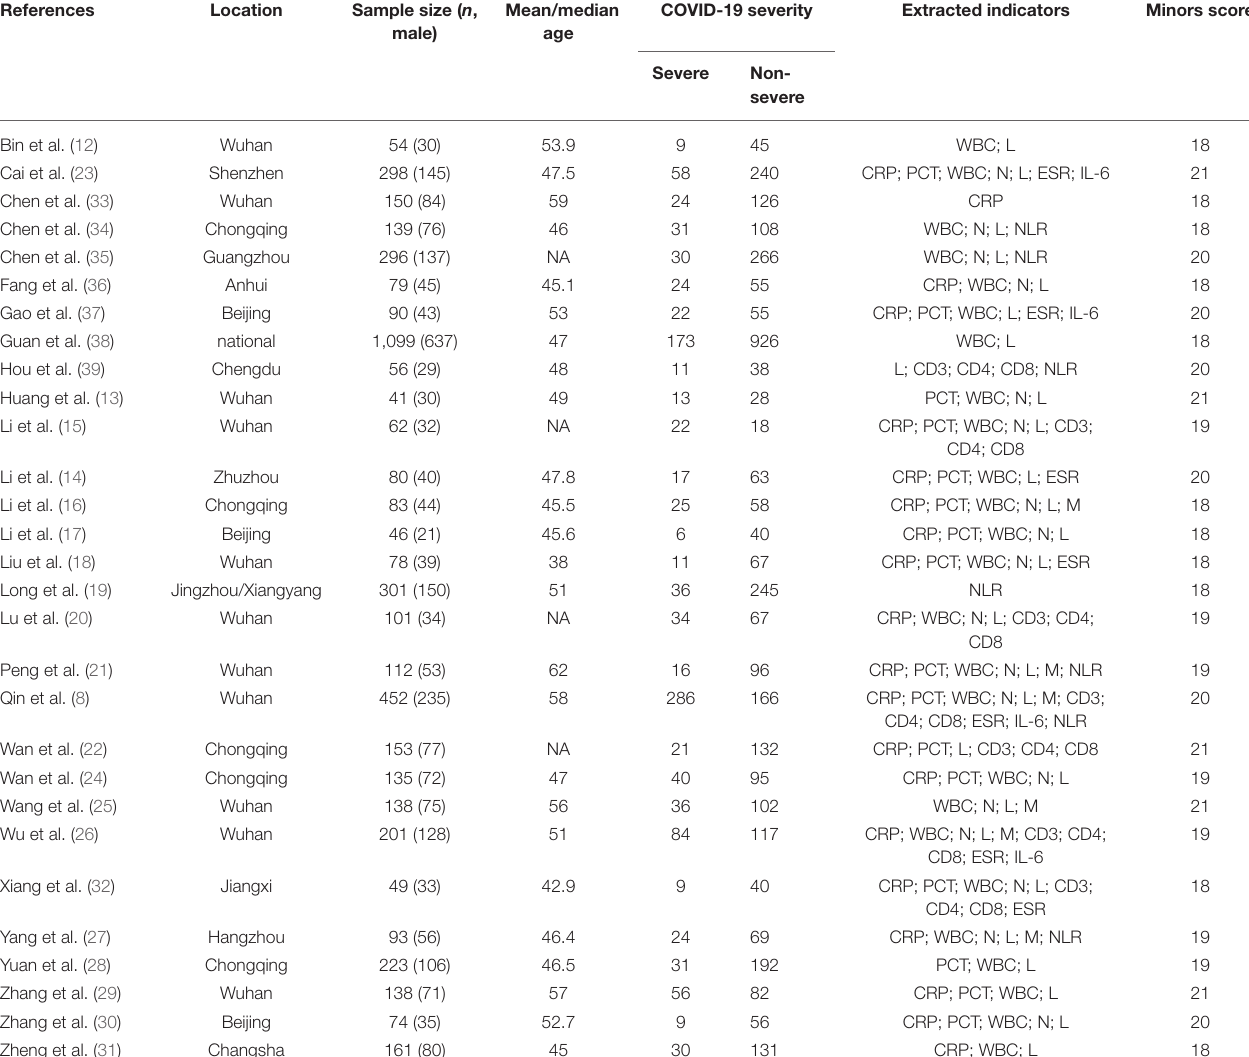
TABLE 1 | Characteristics of included studies in this